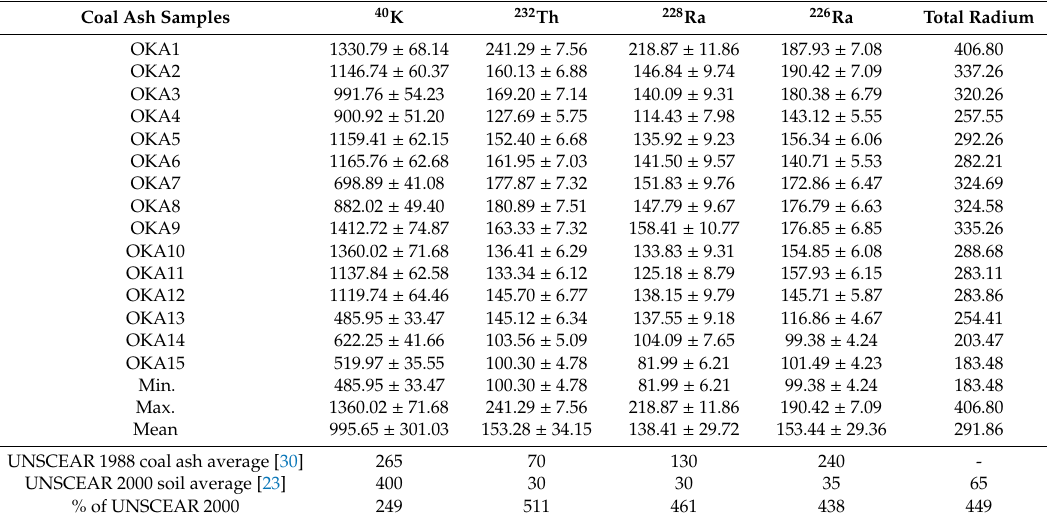
Table 3. Activity concentration of radionuclides in Okaba simulant coal ash samples (Bqkg − 1 ). Coal Ash